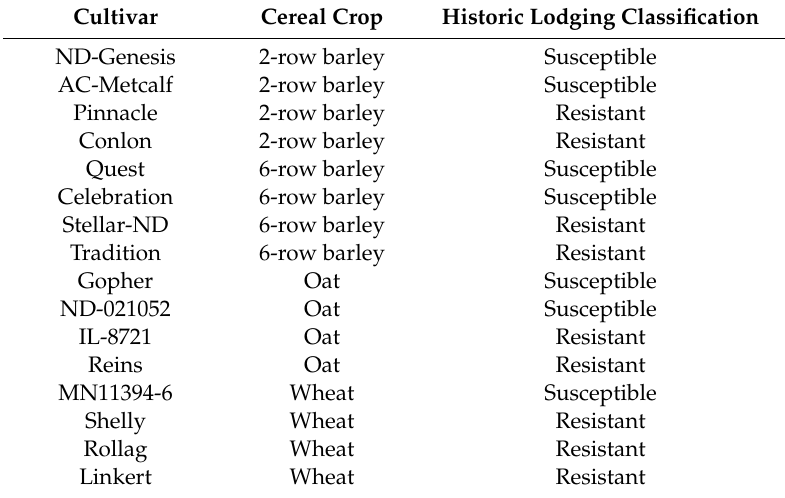
Table 1. Cultivars tested with their historic lodging